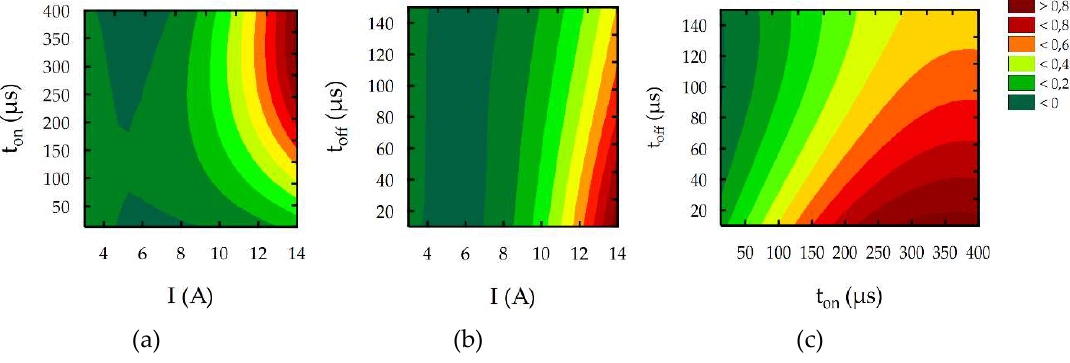
Figure 21. The contour plots of the desirability function for roughing EDM optimization.